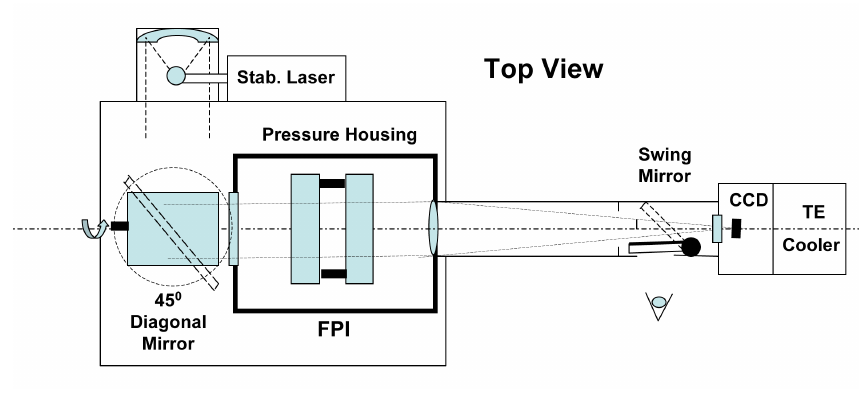
Fig. 1. Schematic of the Arequipa Fabry-Perot interferometer instrument after replacement of the photomuliplier with a bare CCD detector. The diagonal mirror shown is rotated 90 ◦ about the horizontal axis to shift the CCD camera view from the sky to the calibration chamber or the reverse as selected by the computer. The swing mirror allows a view of the etalon chamber while adjusting the etalon plate alignment.